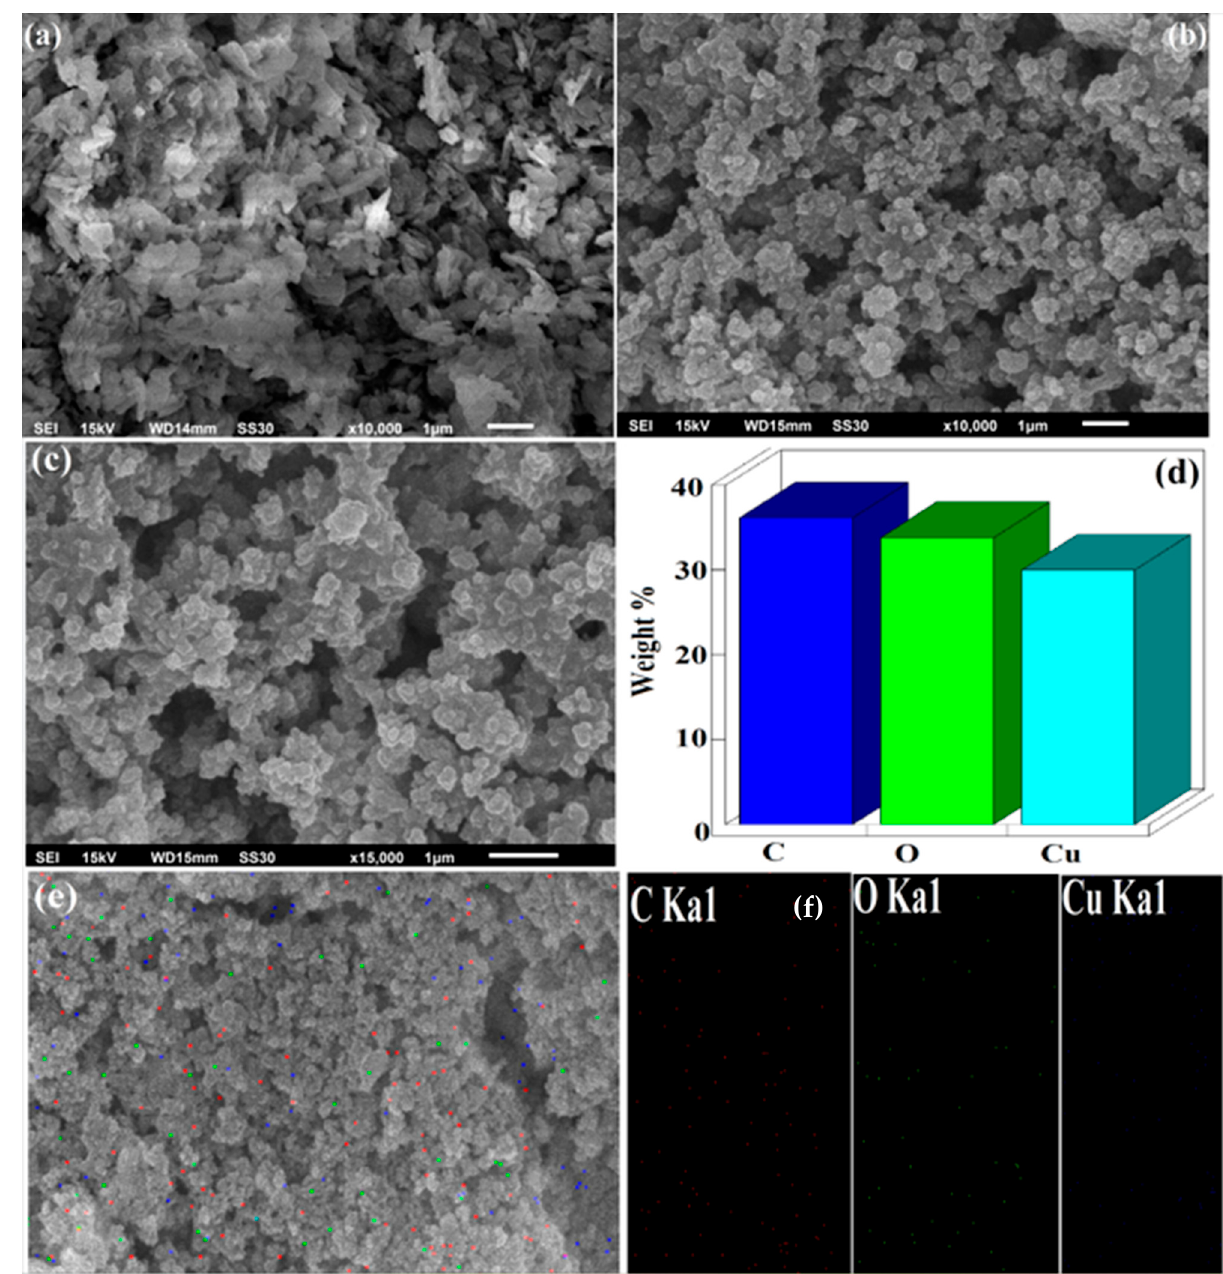
Figure 4. SEM image of ( a ) CuO NRs, ( b , c ) CuO/Alg-Agar BNC at 10,000 and 15,000 magnification range, ( d ) EDX spectra of CuO/Alg-Agar BNC, ( e ) selected area of SEM image of CuO/Alg-Agar BNC with ( f ) elemental mapping